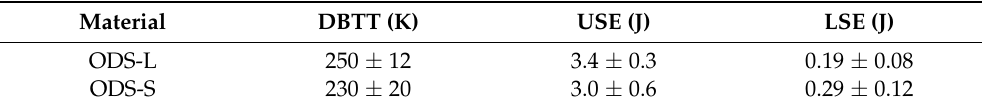
Figure 16. Charpy impact test curves on V-notch samples for the ODS-L and ODS-S steels annealed at 1273 K after HCR along the TS plane. The dashed lines represent the sigmoidal fits in each case. Table 3. Charpy impact test properties for annealed ODS-L and ODS-S at 1273 K after HCR on the TS plane.